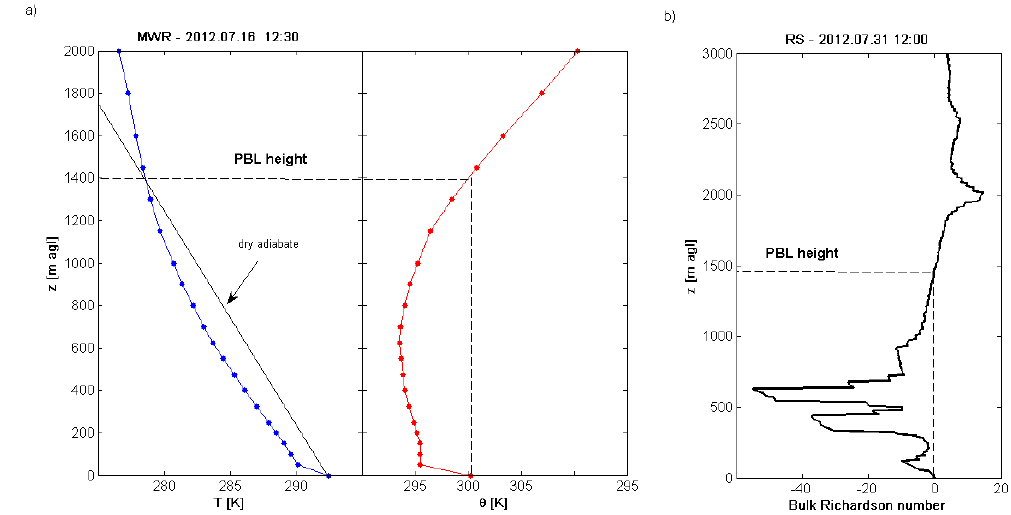
Figure 2. PBL detection methods based on T profiles: (a) parcel method applied to MWR T and θ profiles and (b) bulk Richardson number method applied to the RS θ profile. Both profiles were measured at about 12:00 in convective